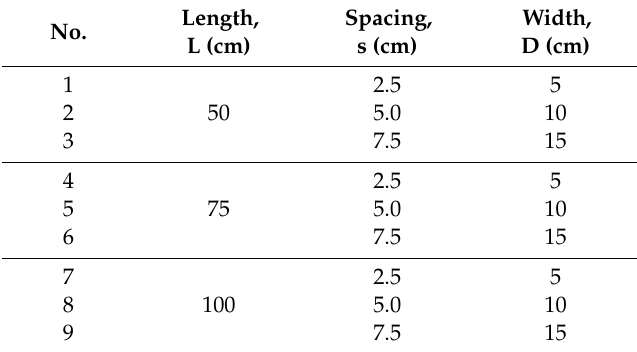
Table 1. Dimensions of the HETDR probe.